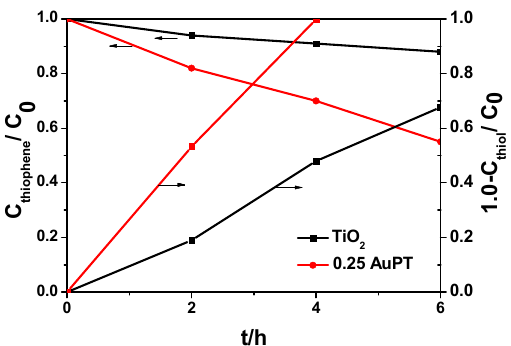
Figure 6. Photocatalytic oxidation of thiophene (left Y axis) and thiol (right Y axis) on the fresh 0.25 AuPT and TiO 2 catalysts under visible-light irradiation ( λ ≥ 420 nm). Reaction conditions: [sulfur concentration] initial = 600 ppm; photocatalyst content: 1 g L − 1 ; O 2 (bubbled into the system); reaction time: 6 h.